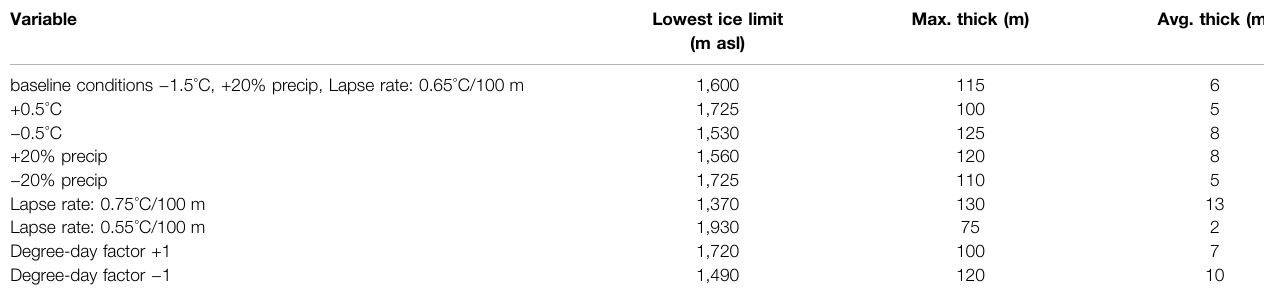
TABLE 4 | Parameters used for modeling of the glacial mass energy balance sensitivity analysis. Variable Lowest ice limit